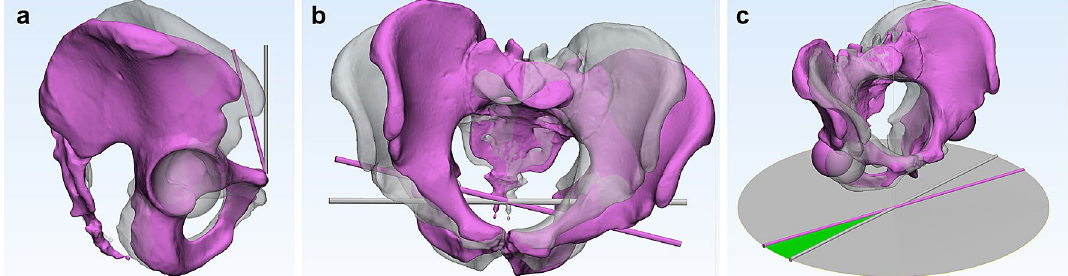
Figure 4. Representation of 3D pelvic orientation. The transparent grey pelvis indicates a neutral position, while the opaque pink pelvis indicates the position with each gyration. MIMICS 20.0 (Materialise, Leuven, Belgium) and 3-matic 12 (Materialise) were used to create the image. ( a ) Flexion: an example of − 15° flexion, ( b ) Obliquity: an example of + 15° obliquity, ( c ) Rotation: an example of − 15° rotation.